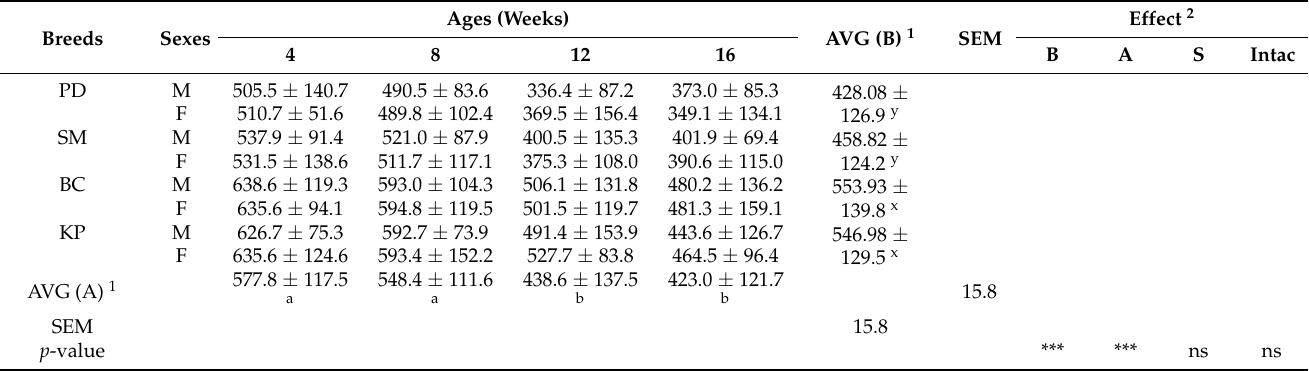
Table 3. Carnosine content (mg/100 g) (Mean ± SD) of breast meat from Pradu Hang Dam (PD), Sri Mok (SM), Black-Chinese (BC), and KU-Phuparn (KP) chickens at different ages and sexes of chickens. Breeds